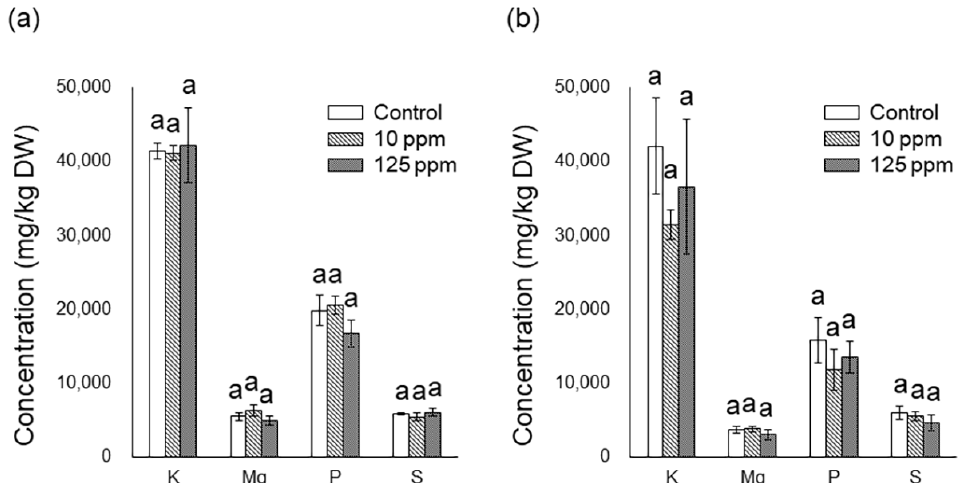
Figure 1. Nutrient element concentrations in Miscanthus sinensis seedlings after incubation in nutrient solution containing 100 µM Al after oosporein treatment. ( a ) Concentration in aboveground parts, and ( b ) concentration in roots. After incubation of 3 h in 0, 10, or 125 ppm solutions of oosporein, the seedlings were transferred to 1/10 Hoagland solution containing 100 µM Al and incubated for 30 days. Data of each bar followed by the same letter (a) are not significantly different among treatment in ANOVA comparisons and post hoc Tukey HSD at p < 0.05 ( n = 4). Error bars represent ±SE.